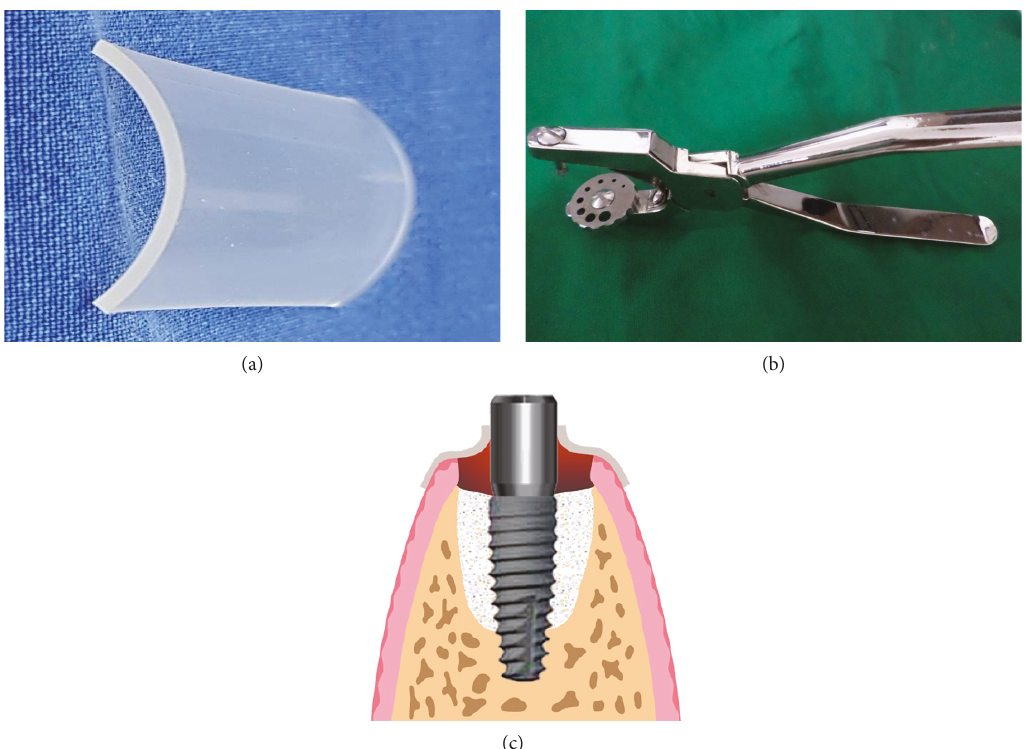
Figure 1: (a) Medical grade U-shaped silicone sheet. (b) Punching tool to produce silicone caps. (c) A schematic diagram of a silicone cap placed over a cylinder-type healing